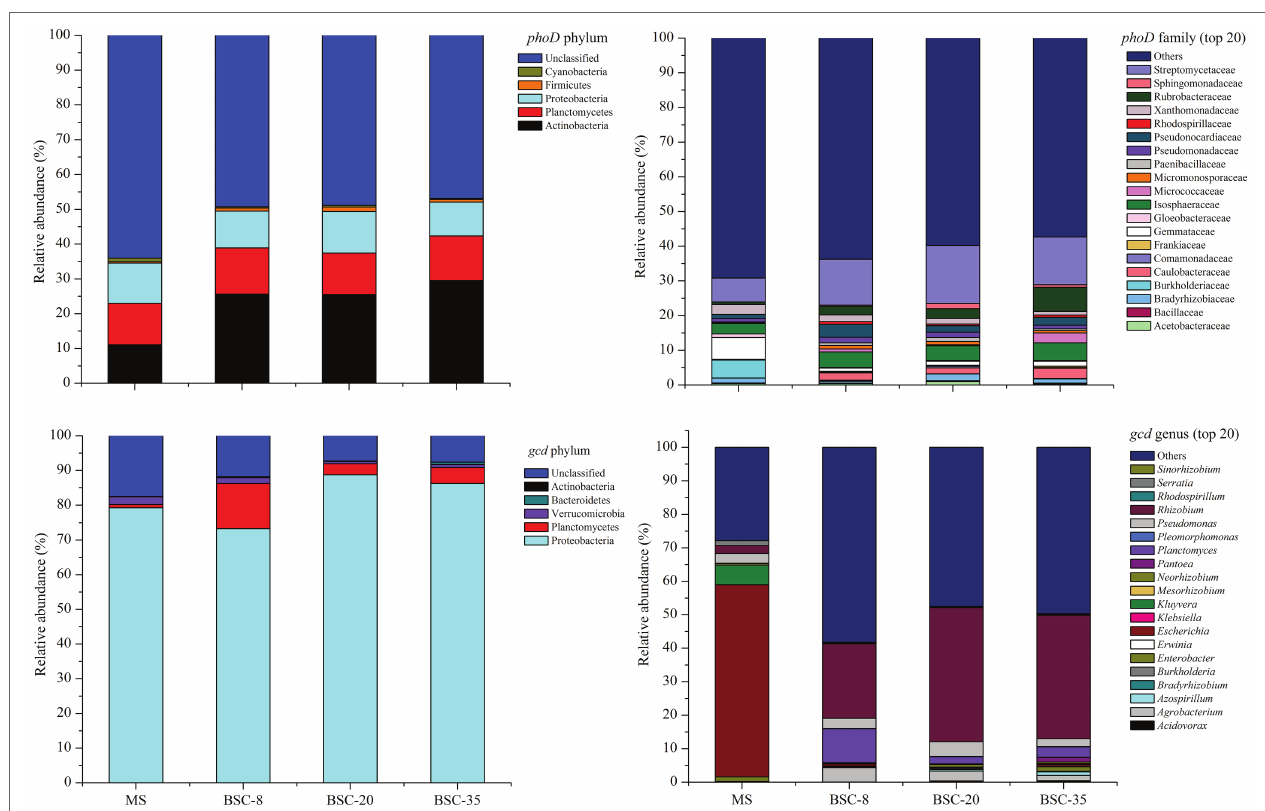
FIGURE 3 | Relative abundance of the dominant taxa of phoD and gcd communities (average of three sites) across different sites. MS, moving sand dune; BSC-8, 8-year-old biological soil crust; BSC-20, 20-year-old biological soil crust; and BSC-35, 35-year-old biological soil